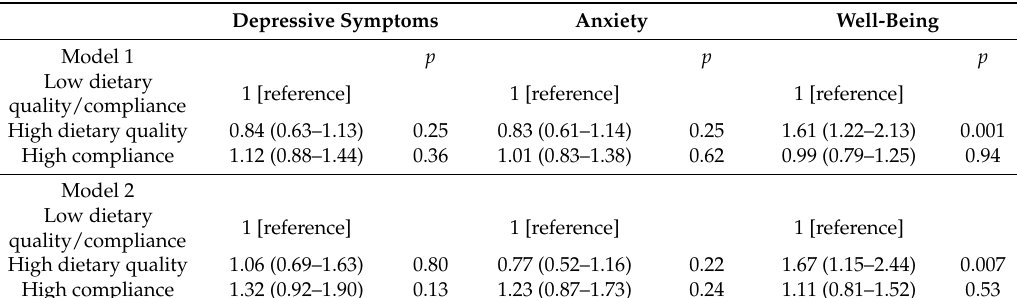
Table 2. Odds ratios (95% CI) for depressive symptoms, anxiety and well-being according to dietary quality and compliance with food pyramid recommendations among the Mitchelstown cohort. Depressive Symptoms Anxiety Well-Being Model 1 p p p 1 [reference] 1